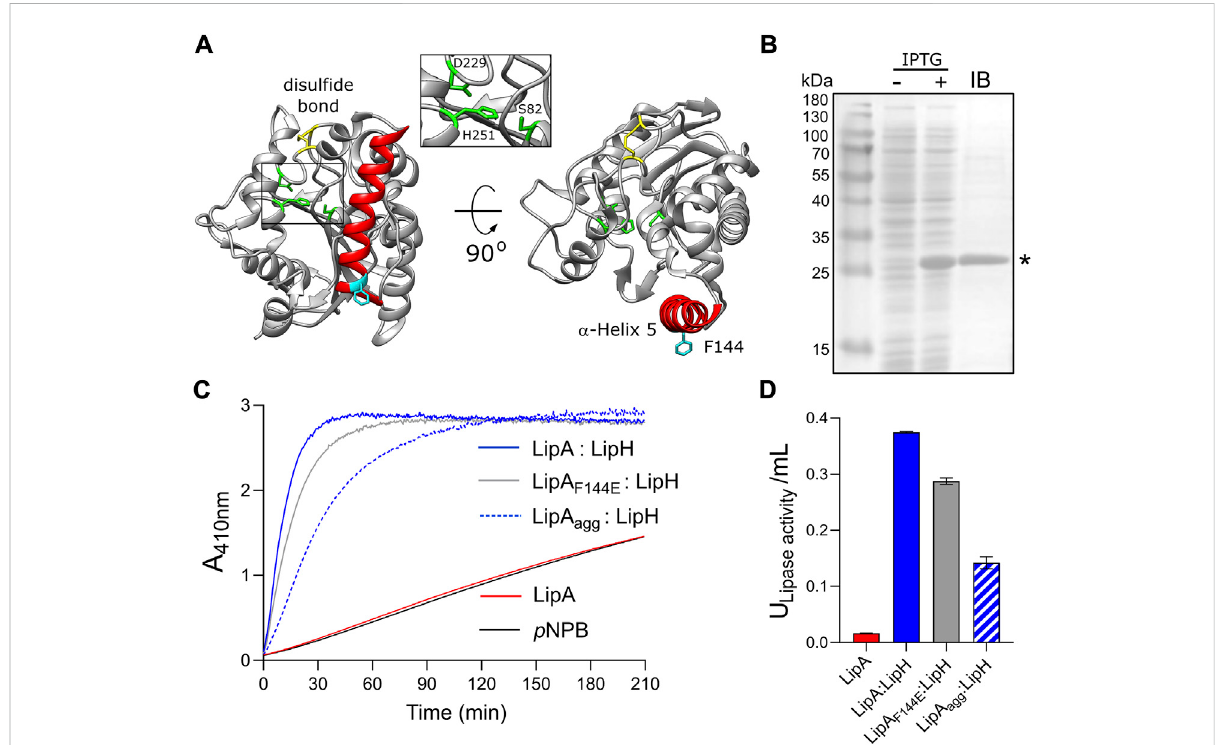
FIGURE 1 LipaseAfrom Pseudomonasaeruginosa PAO1. (A) StructureofthelipaseLipA(PDBID:1EX9).ThecatalytictriadofSer-82,Asp-229andHis-251 is shown in green, the disul fi de bridge between Cys-183 and Cys-235 is shown in yellow. The α -helix 5 forming the lid domain is shown in red, with the residue F144 in cyan. (B) LipA expression and puri fi cation visualized on SDS-PAGE. Cell lysates prior to adding IPTG ( “ - ” ) and after 2 h of expression( “ + ” )areshown.Lane “ IB ” :isolatedinclusionbodies.LipAbandisindicatedwithanasterisk. (C) Lipaseactivity invitro mediatedbythe foldase LipH. Change in absorbance at 410 nm is associated with hydrolysis of the substrate, para-nitrophenyl butyrate ( p NPB). Once folded in presenceofLipH,thewild-type LipAandthemutantLipA F144E areabletohydrolyse p NPB(blueandgreysolidtraces,respectively).Pre-incubationof the wild-type lipase in the absence of LipH (LipA agg ) leads to the partial inhibition of hydrolysis (blue dashed trace). LipA activity in the absence of LipH (red trace), and the autohydrolysis of the substrate (black trace) are indicated. (D) Quanti fi cation of the hydrolytic activity of LipA. The lipase activity was calculated based on the colorimetric signal after 15 min of p NPB hydrolysis (panel C). The assays wereperformed intechnical triplicates, the mean values and the standard deviations (SD) are